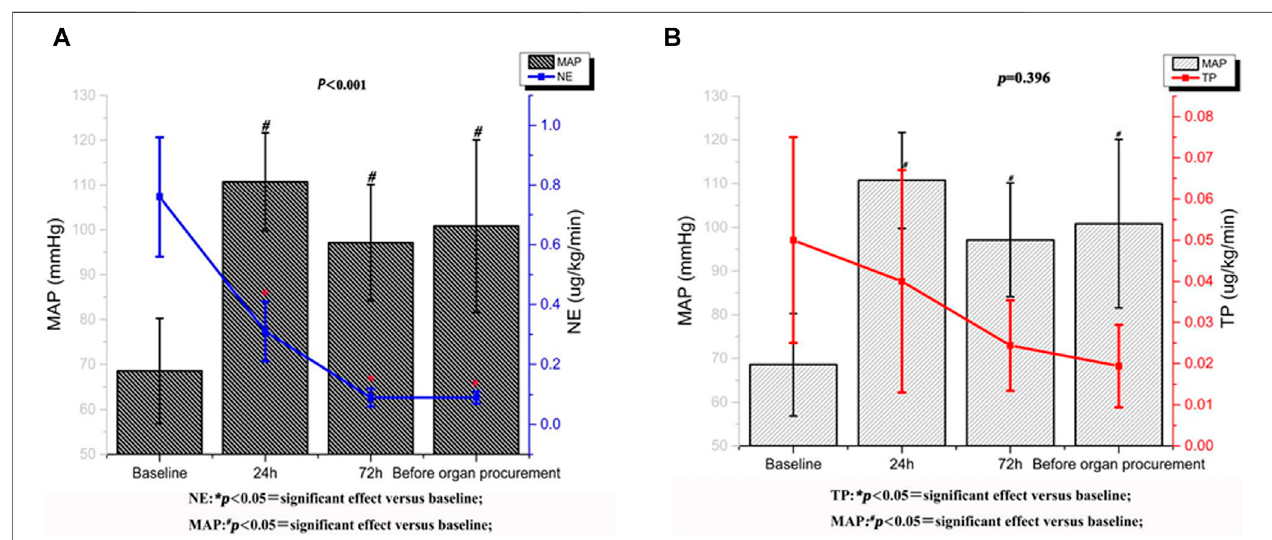
FIGURE 1 | Norepinephrine and terlipressin requirement variations and mean arterial pressure trend after treatment with terlipressin.